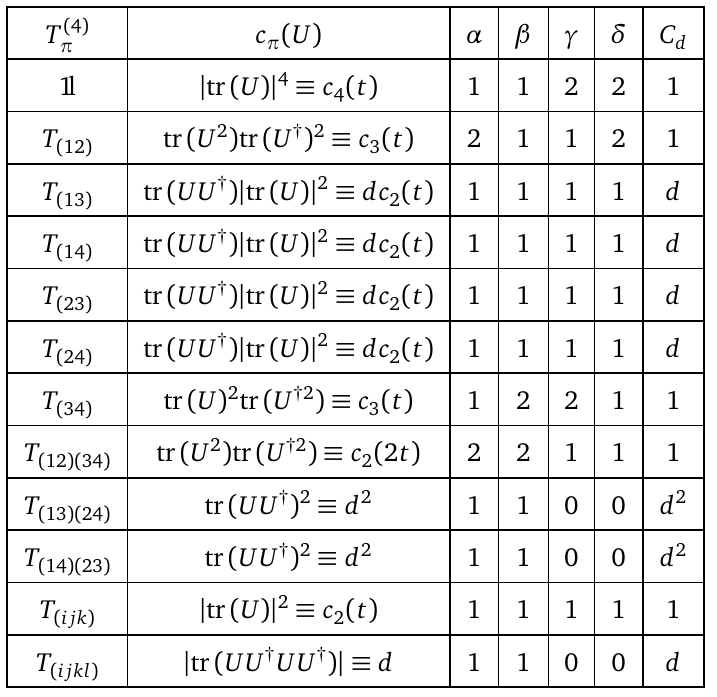
Table 4: Calculation of the spectral functions c ( 4 ) responding exponents α , β , γ , δ and the constant C ( t ) and c ( t ) is defined in Eq. c 3 4